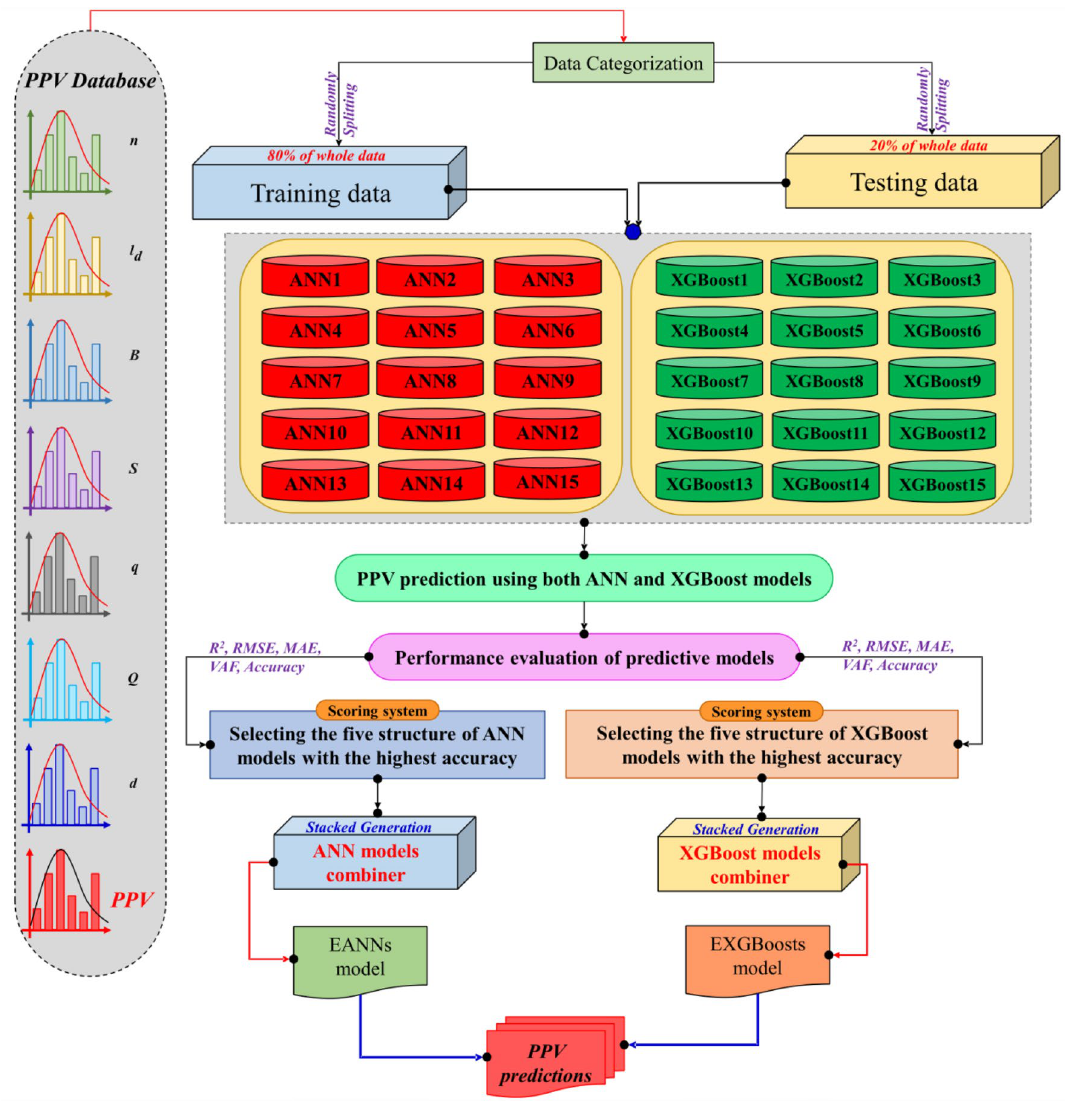
Figure 3. A schematic representation of EANNs and EXGBoosts methods for predicting